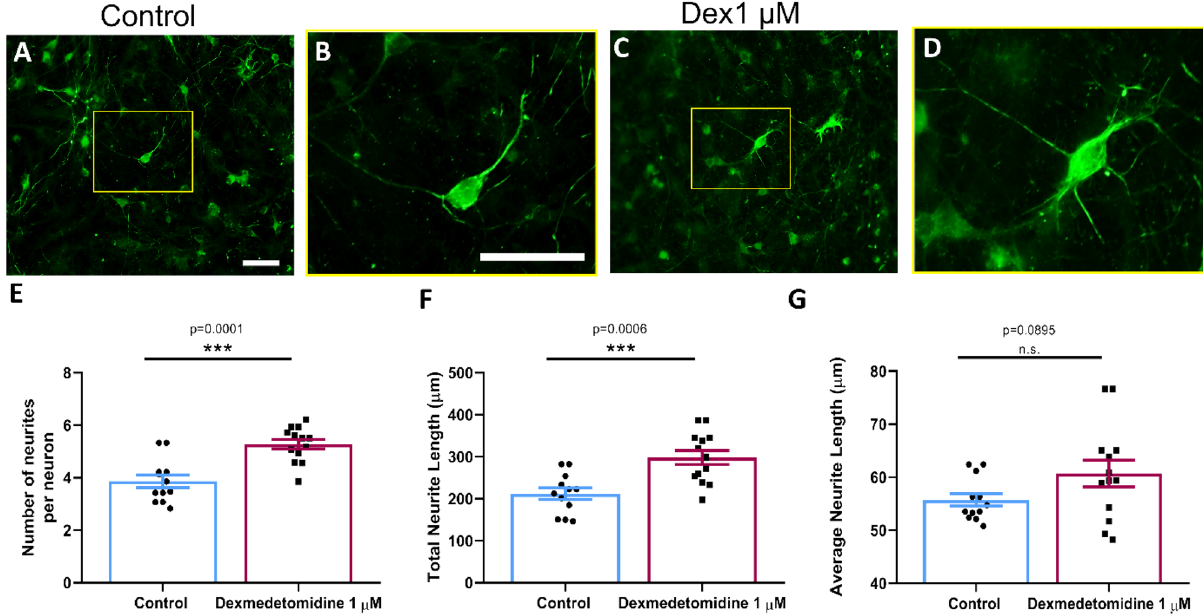
Figure 2. Exposure to 1 μM dexmedetomidine modified neuronal morphology. Representative fluorescent images of neurons stained with neurofilament. ( A ) Control cells and ( B ) higher magnification of the region of interest and ( C ) dexmedetomidine 1 μM treated cells and ( D ) higher magnification of the region of interest. Quantification of ( E ) number of neurites per neuron: control = 3.86 ± 0.239, dexmedetomidine 1 μM = 5.27 ± 0.185. Values are mean ± SEM t = 4.672, df = 21.18, ***p = 0.0001 by two-tailed t test, Welch- corrected ( F ) total neurite length: control = 211.9 ± 13.81, dexmedetomidine 1 μM = 298.0 ± 16.82. Values are mean ± SEM t = 3.956, df = 22.48, ***p = 0.0006 by two-tailed t test, Welch-corrected and ( G ) average neurite length: control = 55.74 ± 1.185, dexmedetomidine 1 μM = 60.71 ± 2.492. Values are mean ± SEM t = 1.8, df = 17.09, P = 0.0895 by two-tailed t test. Bars indicate ± SEM. Scale bars indicate 50 μm n = 12 (control) and n = 13 (dexmedetomidine 1 μM) dishes per condition, 15–20 images per plate. ( A , C , B , D ) show the same scale,